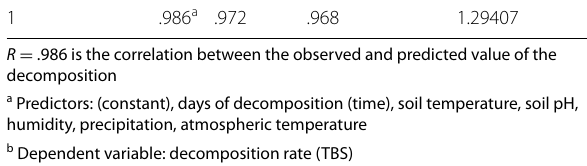
Table 6 Regression model for decomposition rate